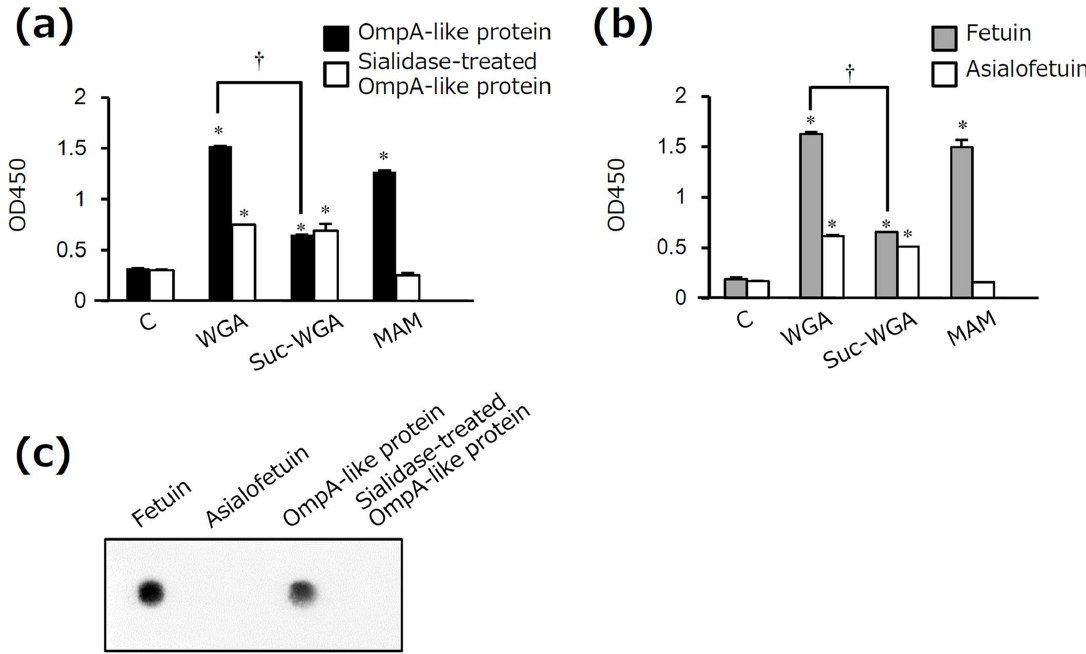
Fig 4. Detection of Sia in OmpA-like protein. (a, b) The wells of 96-well microtiter plates were coated with 5 μ g/ml OmpA- like protein, sialidase-treated OmpA-like protein, fetuin, or asialofetuin for 18–24 h. After blocking,the wells were incubated with 5 μ g/ml control (C)-biotin, WGA-biotin, succinylated WGA (Suc-WGA)-biotin, or MAM-biotin for 3 h. Bindingwas determinedby ELISA using streptavidin-HRP. Data are expressed as the mean ± SD (n = 3). * , P < 0.01 for comparison with control-biotin. † , P < 0.01 for comparison with WGA-biotin. (c) OmpA-like protein, sialidase-treated OmpA-like protein, fetuin, and asialofetuin were analyzedby dot blotting with anti-Sia α